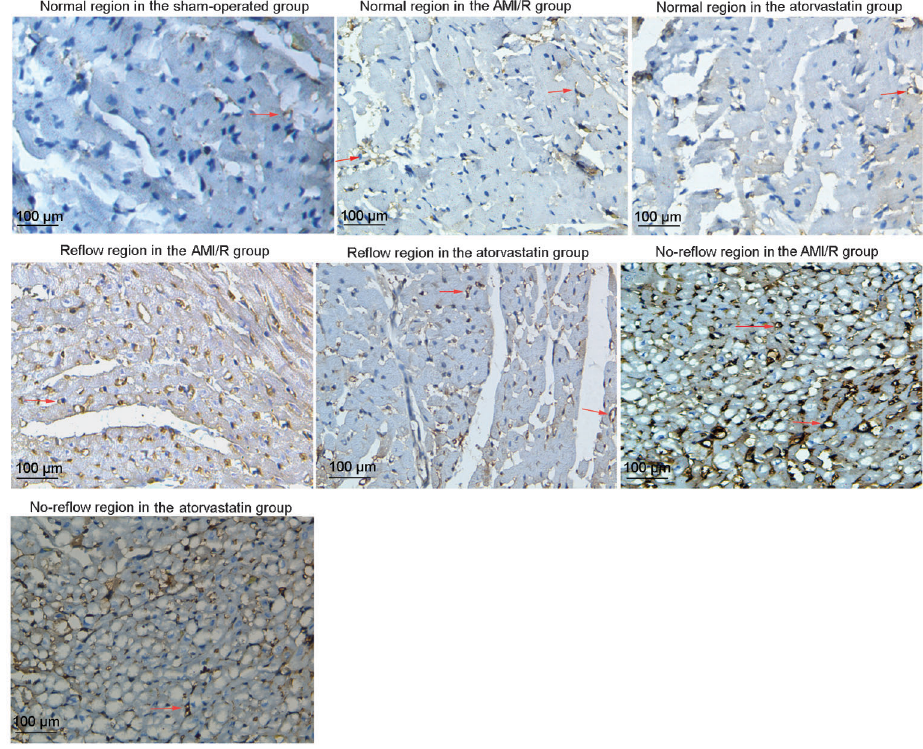
Figure 4. Expression of IFN- c in different regions of the myocardium in the three groups after 4 h of occlusion and 2 h of reperfusion (IHC, DAB staining, 200 6 ). Positive IFN- c expression was seen in vascular endothelial cells (as shown by arrows). AMI/R: acute myocardial infarction and reperfusion.